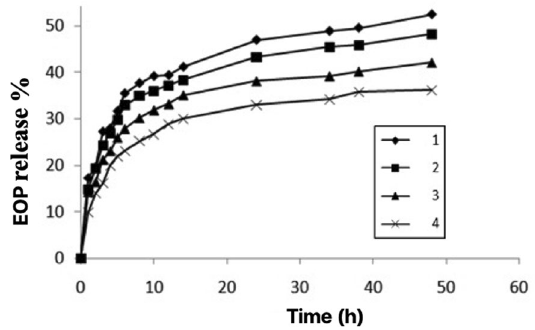
Figure 5. The different ratio scaffolds/EOP in 1, 2, 3, and 4 with loading EOP is 52.1, 36.2, 28.3, and 24.4%.